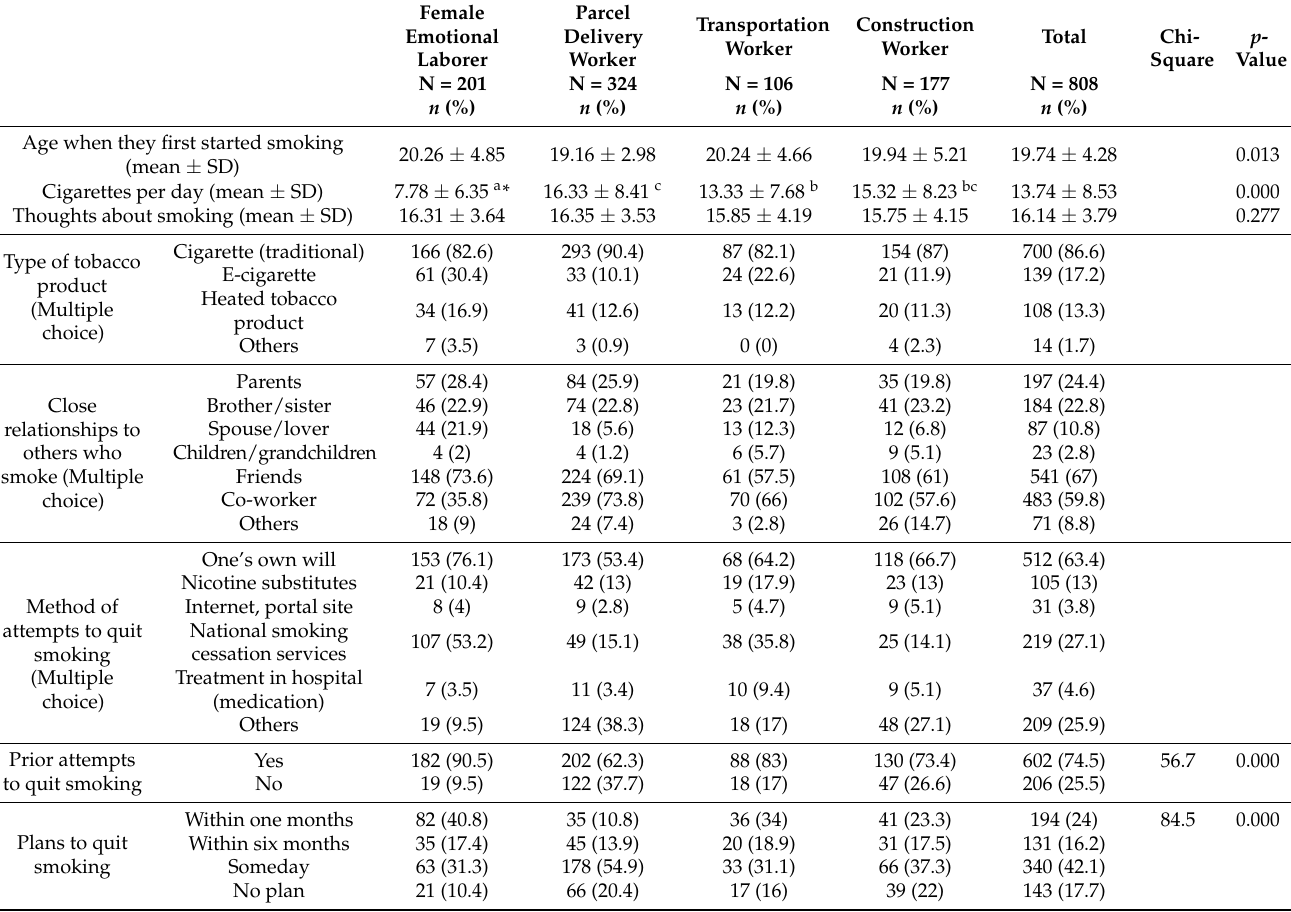
Table 2. Participants’ smoking-related